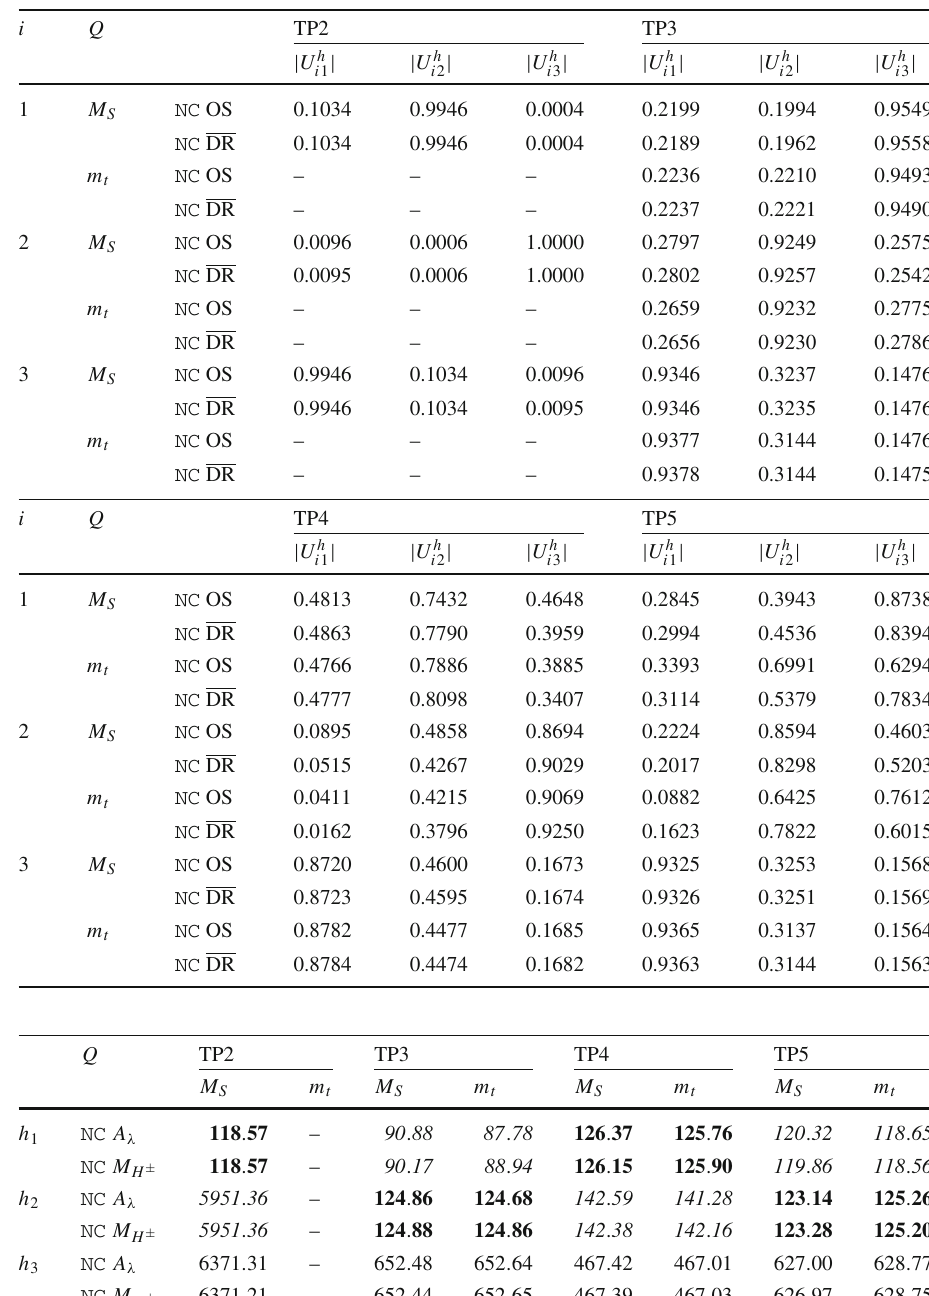
the mixing-matrix elements of the CP -even scalar sector for TP2–TP5 when using the OS or the DR renormalization of the top/stop sector within